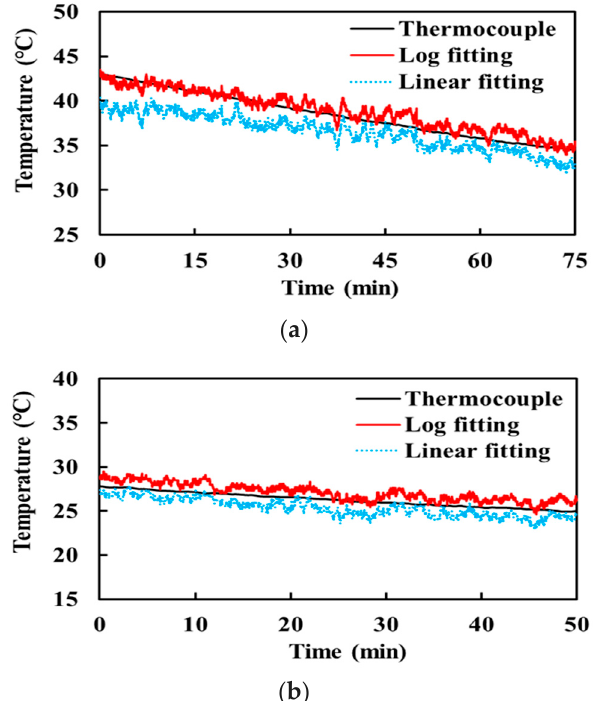
Figure 8. Measured temperature of water by the temperature sensor (thermocouple) and radiometer ( a ) from 43.1 to 34.5 °C and ( b ) from 27.8 to 25.0 °C. ( a ) from 43.1 to 34.5 ◦ C and ( b ) from 27.8 to 25.0 ◦